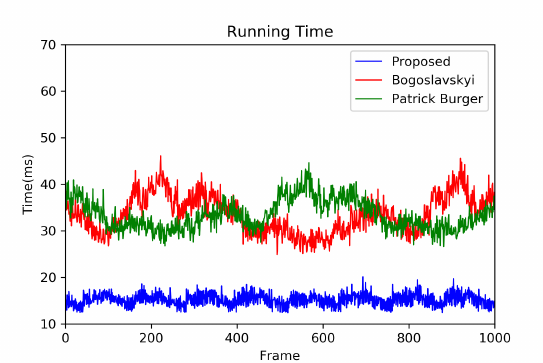
Figure 12. The red curve is the running time of the Bogoslavskyi method, the green is Patrick Burger’s method, and the blue is the method we proposed. The proposed method has relatively little running time.